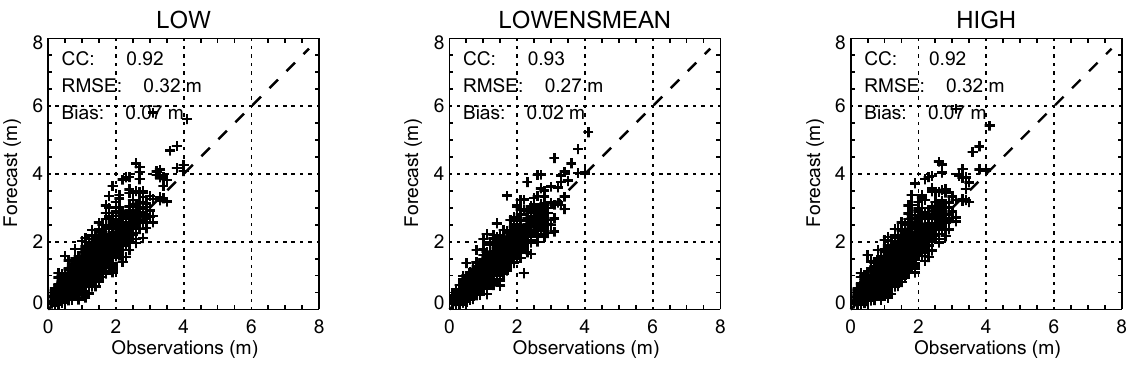
Figure 6. As for Fig. 5 but for the Arkona WR